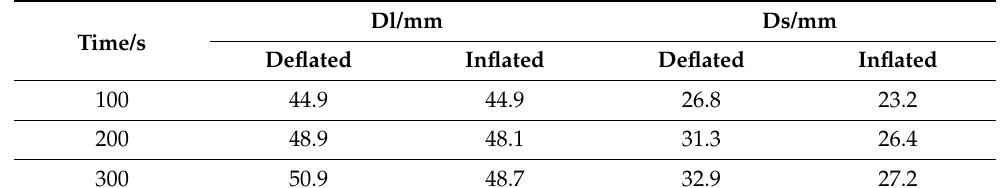
Table 11. Simulation data (ablation power 60 W).